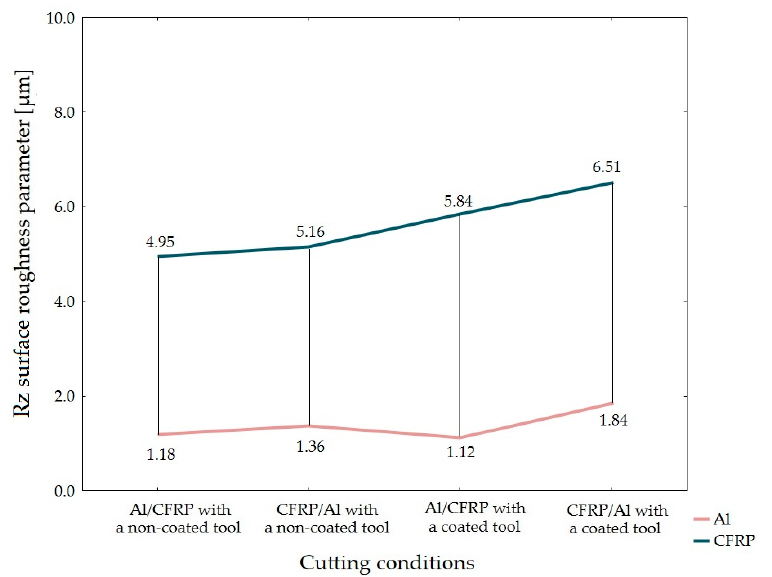
Figure 12. Surface uniformity based on the value of Rz surface roughness parameter obtained de- pending on the machining configuration and the type of tool.